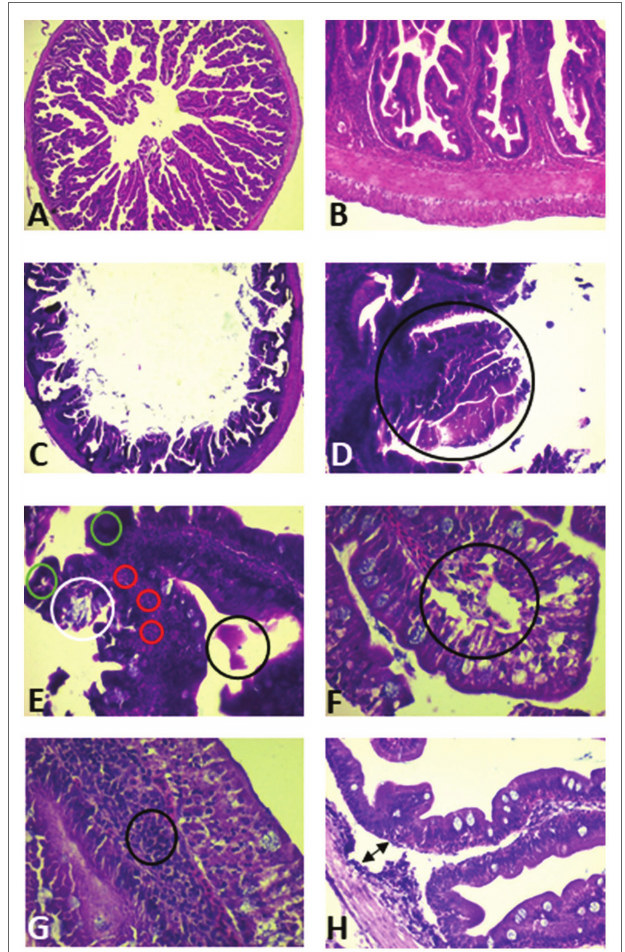
FIGURE 6 | Photomicrograph of the anterior intestine (AI) of S. aurata juveniles fed with control diet (A,B) and with the highest dose of AFB1 (2 mg AFB1 kg − 1 fish feed) for 85 days (C–H) . (A) AI of the control group (H&E 2x). (B) AI showing different intestinal layers and villi in detail (H&E 10x). (C) AI of S. aurata juveniles exposed to AFB1 (H&E 2x). (D) AI showing in detail: necrosis, shortening of villi, and hypoplasia of goblet cells (GC; black circle; H&E 10x); (E) necrosis of epithelial villi (green circles), villus sloughing (white circle), hyperemia in submucosa layer (red circles), and exudate in the intestinal lumen (black circle; H&E 20x); (F) oedema in the apical end of the villus (black circle; H&E 40x); (G) infiltration of mononuclear cells in mucosa submucosa layer of a villus (H&E 40x); and (H) subepithelial spaces (arrow; H&E